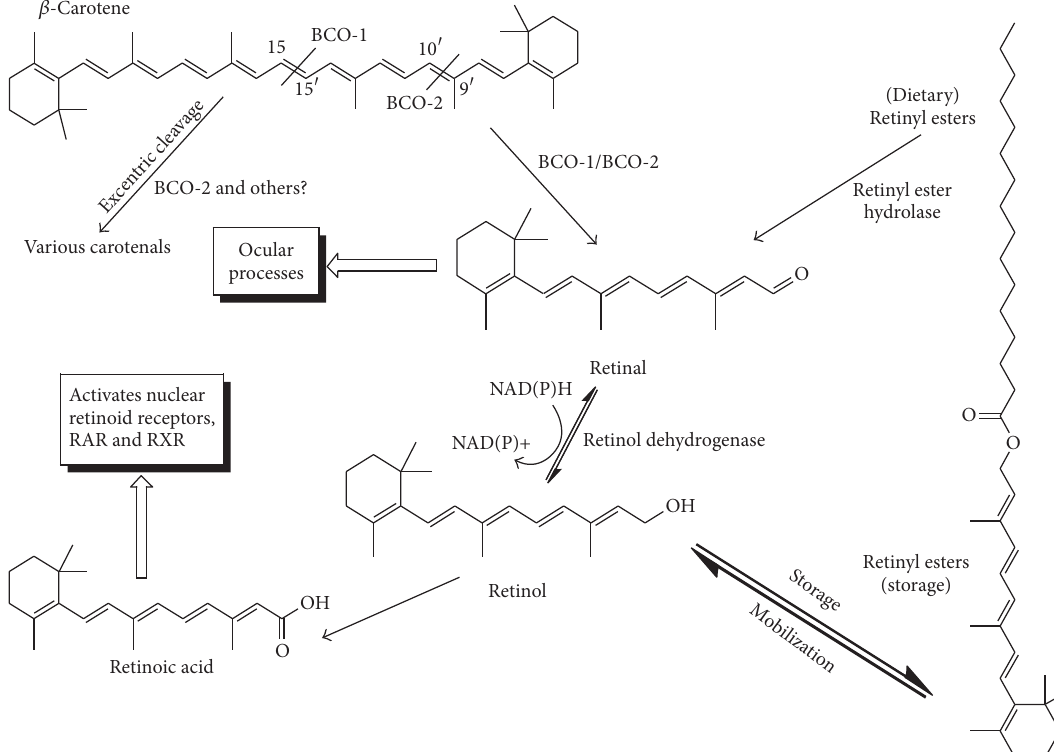
Figure 1: Simplified schematic of the major metabolic pathways of 𝛽 -carotene and retinoids. BCO-1, 𝛽 , 𝛽 -carotene 15,15 󸀠 -oxygenase; BCO-2, 𝛽 , 𝛽 -carotene 9,10 󸀠